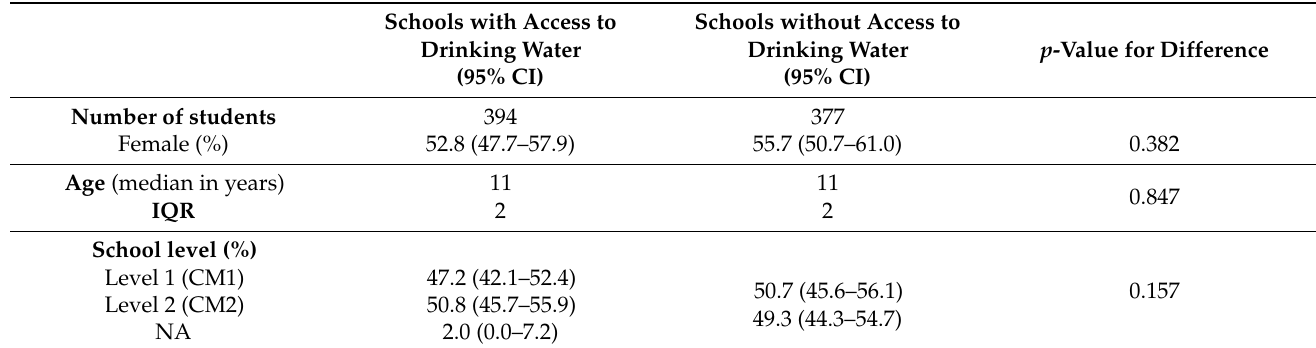
Table 1. Participant characteristics by access to drinking water 1